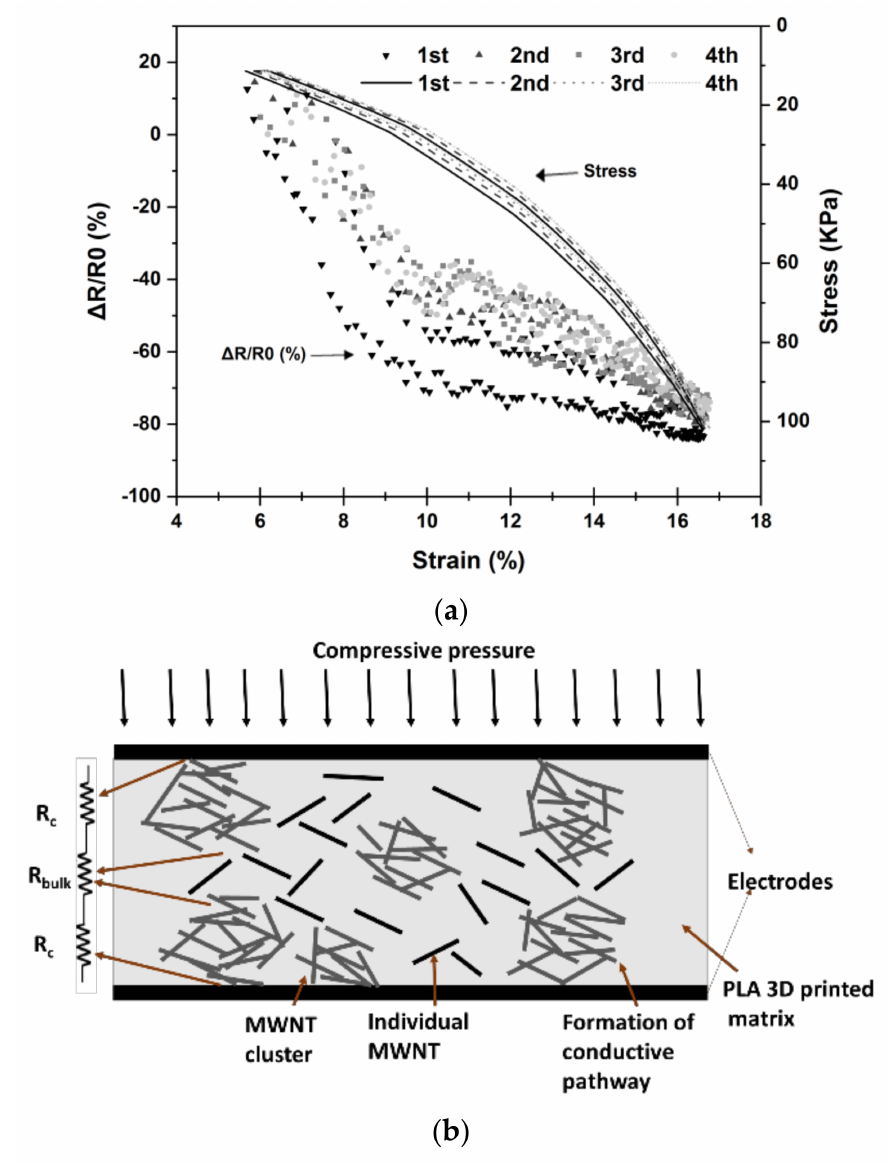
Figure 6. Piezoresistive behavior of 3D-printed PLA/1 wt.% MWNT nanocomposite: ( a ) Synchronism of A r with stress versus deformation. ( b ) Schematic diagram of the transduction mechanism of PLA/1 wt.% MWNT nanocomposite sandwiched between two metal electrodes towards compressive pressure. The electrical model of the FSR consists of a series of connections between the bulk (tunneling) resistance ( R bulk ) and the contact resistance ( R c